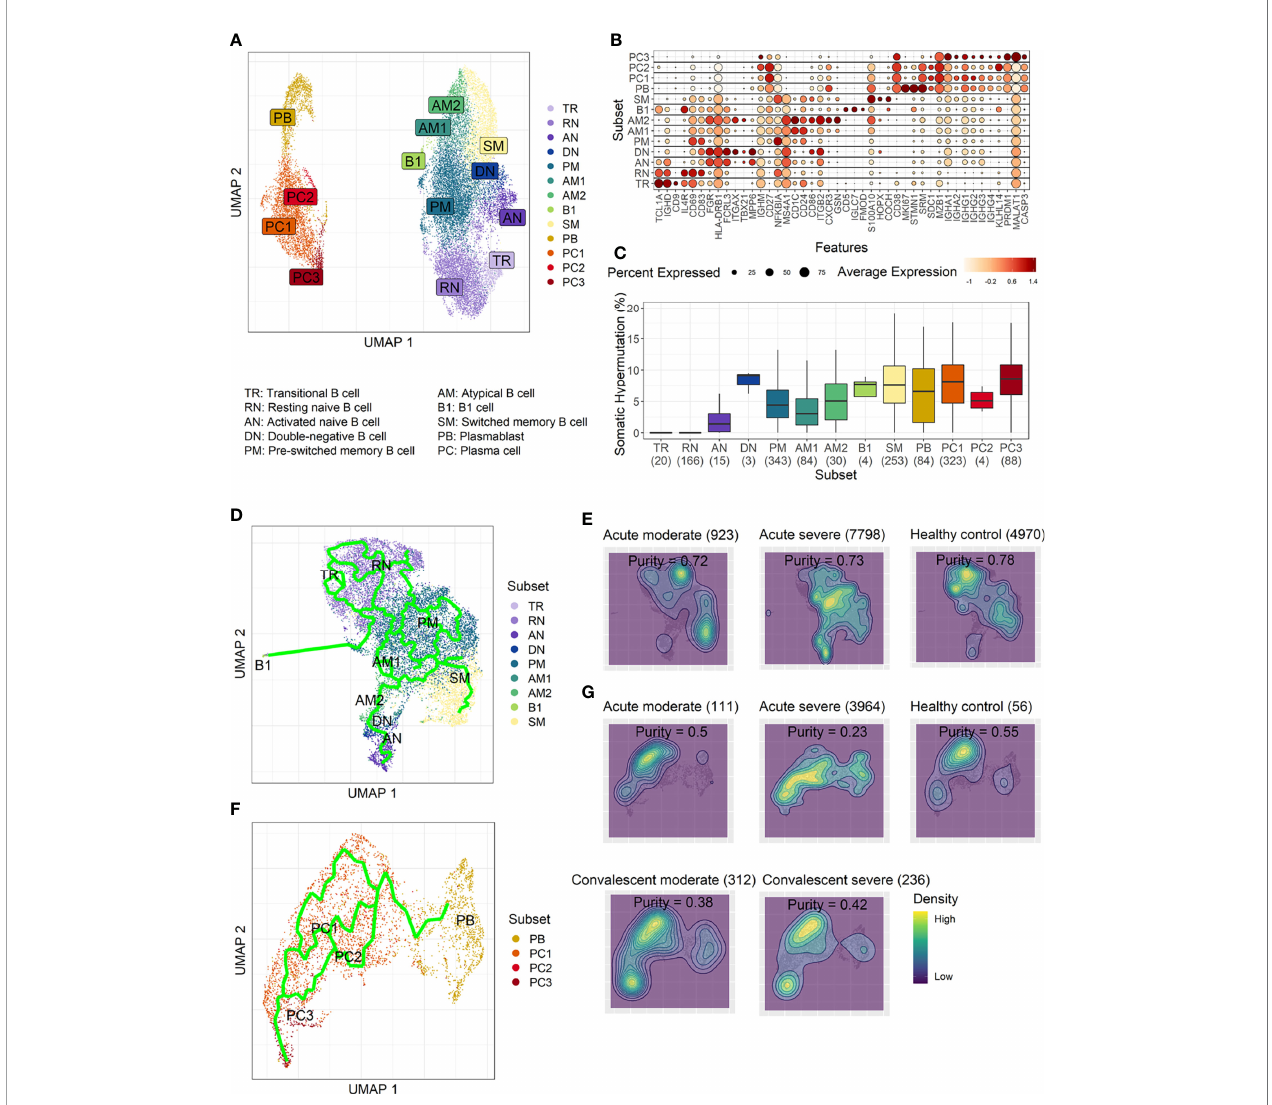
FIGURE 3 | Characterization of B-cell subsets in detail using transcriptional signatures and somatic hypermutation rate. (A) Uniform Manifold Approximation, and Projection (UMAP) for clustered B-cell subsets. (B) Dot plot for the most signi fi cant DEGs of each subset. Diameter presents the percentage of cells expressing the DEG and with color for expression level. (C) Boxplots for a percentage of somatic hypermutation rate of IGH of the indicated subset. The number of BCR sequences used for one boxplot is stated within the blanket. (D) Trajectory UMAP for subsets of naïve and memory B cells with lines of potential differentiation lineages. (E) Cell density on trajectory UMAP of naïve and memory B-cell subsets. The number of cells and expression purity is displayed for the indicated patient group. (F) Trajectory UMAP for plasmablasts and plasma cell subsets. (G) Cellular densities on the UMAP of plasmablasts and plasma cell convalescent stage, where both groups showed PC1-biased ( Figure 3G , upper panels). Severe cases presented denser cellular densities, as well as higher PC3 at the terminal stage plasmablasts and slightly biased cellular density toward the ( Figure 3G ). The relative proportion of B-cell population PC2 subset with widely spreading over the plasma cell associated EF B-cell response (AN, DN, and AM2), as well as population during the acute stage. Conversely, the patients the aberrant PC2 subset, was signi fi cantly higher in severe with moderate cases showed more convergent patterns patients, not in moderate group, during the acute phase of toward PC1. Moreover, the calculated expression purity also infection when compared to the healthy control ( Figure 4 ). con fi rmed higher variation in gene expression in the severe Moreover, while the proportion of putative EF B-cell subsets group (0.23), yet a relatively lower expression purity value when (AN and AM B cells) was not statistically signi fi cant ( p = 0.2), it compared to the moderate patients (0.5). The observed was noticeably higher in deceased patients compared to those difference in cellular distribution between the two groups who recovered in ICU ( Supplementary Figure 7 ). during the acute phase became marginal during the